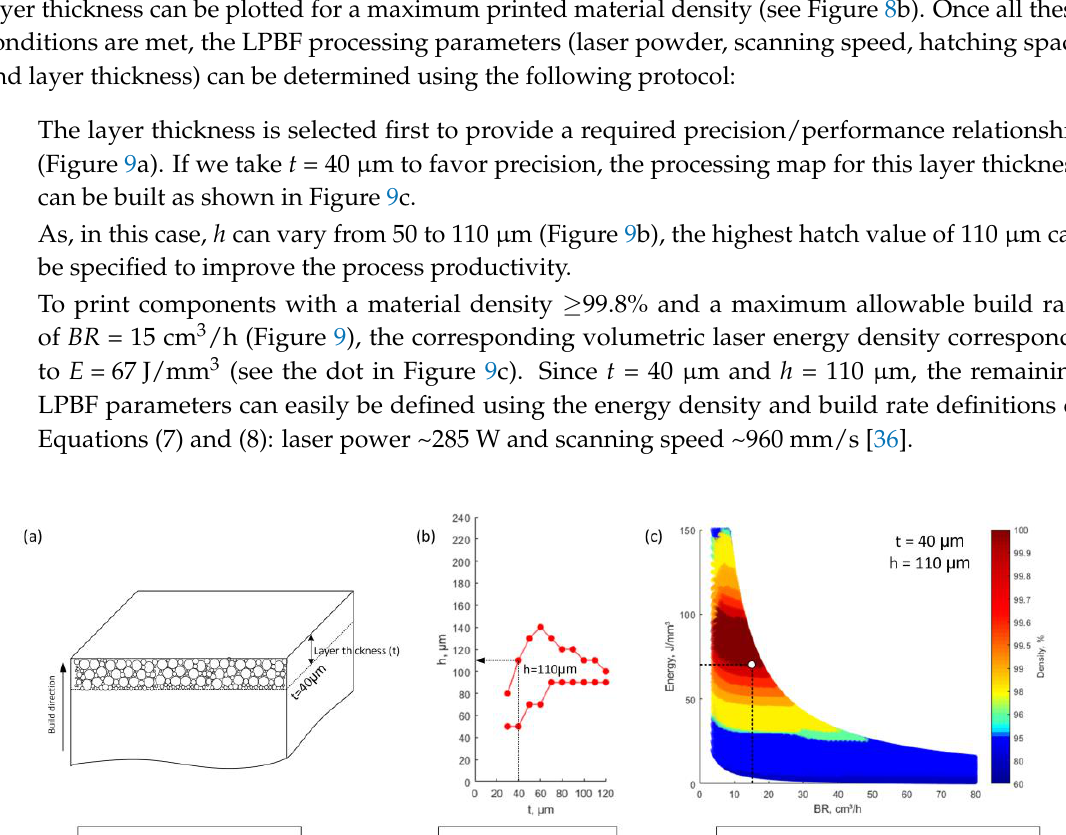
Figure 8. Hatching space/Layer thickness relations: ( a ) density as a function of the h/t ratio; ( b ) hatching space as a function of the layer thickness for maximum density  99.5% (IN625, AlSi10Mg and Ti64 powders for an EOS M280 LPBF system).